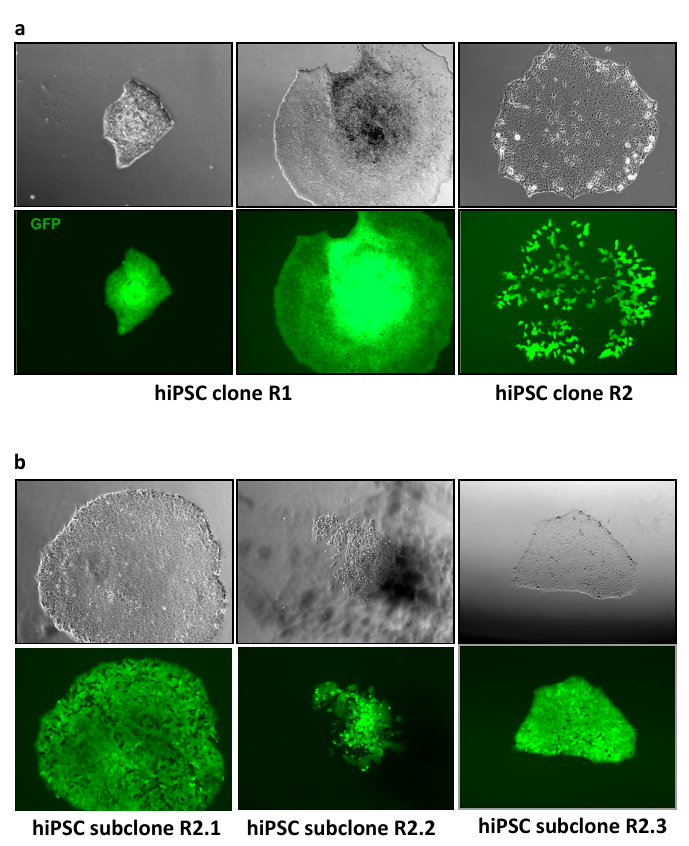
Figure 2. Scheme of microcell mediated chromosome transfer (MMCT) method used in this paper. ( a ) Schematic representation of alphoid tetO -HAC-GFP vector. ( b ) MMCT of the alphoid tetO -HAC-GFP into human pluripotent stem cells (iPSCs) with the use of mouse leukemia virus envelop protein (Env Δ R) as a cell fusion agent and latrunculin B as a cytoskeleton disruptor.